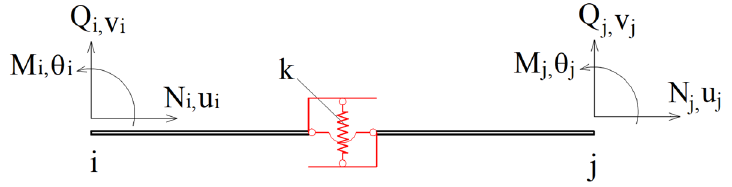
Figure 6. Beam member.